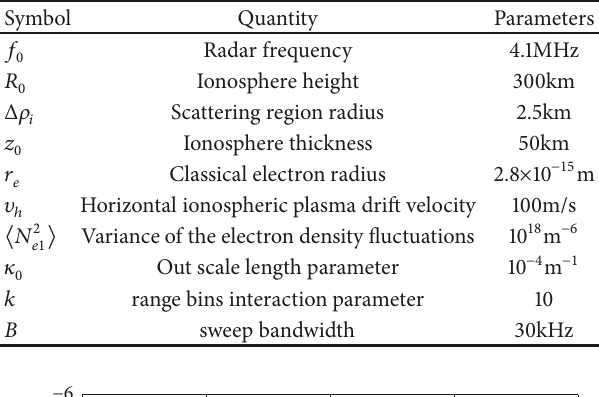
Table 1: Main parameters in the simulation.